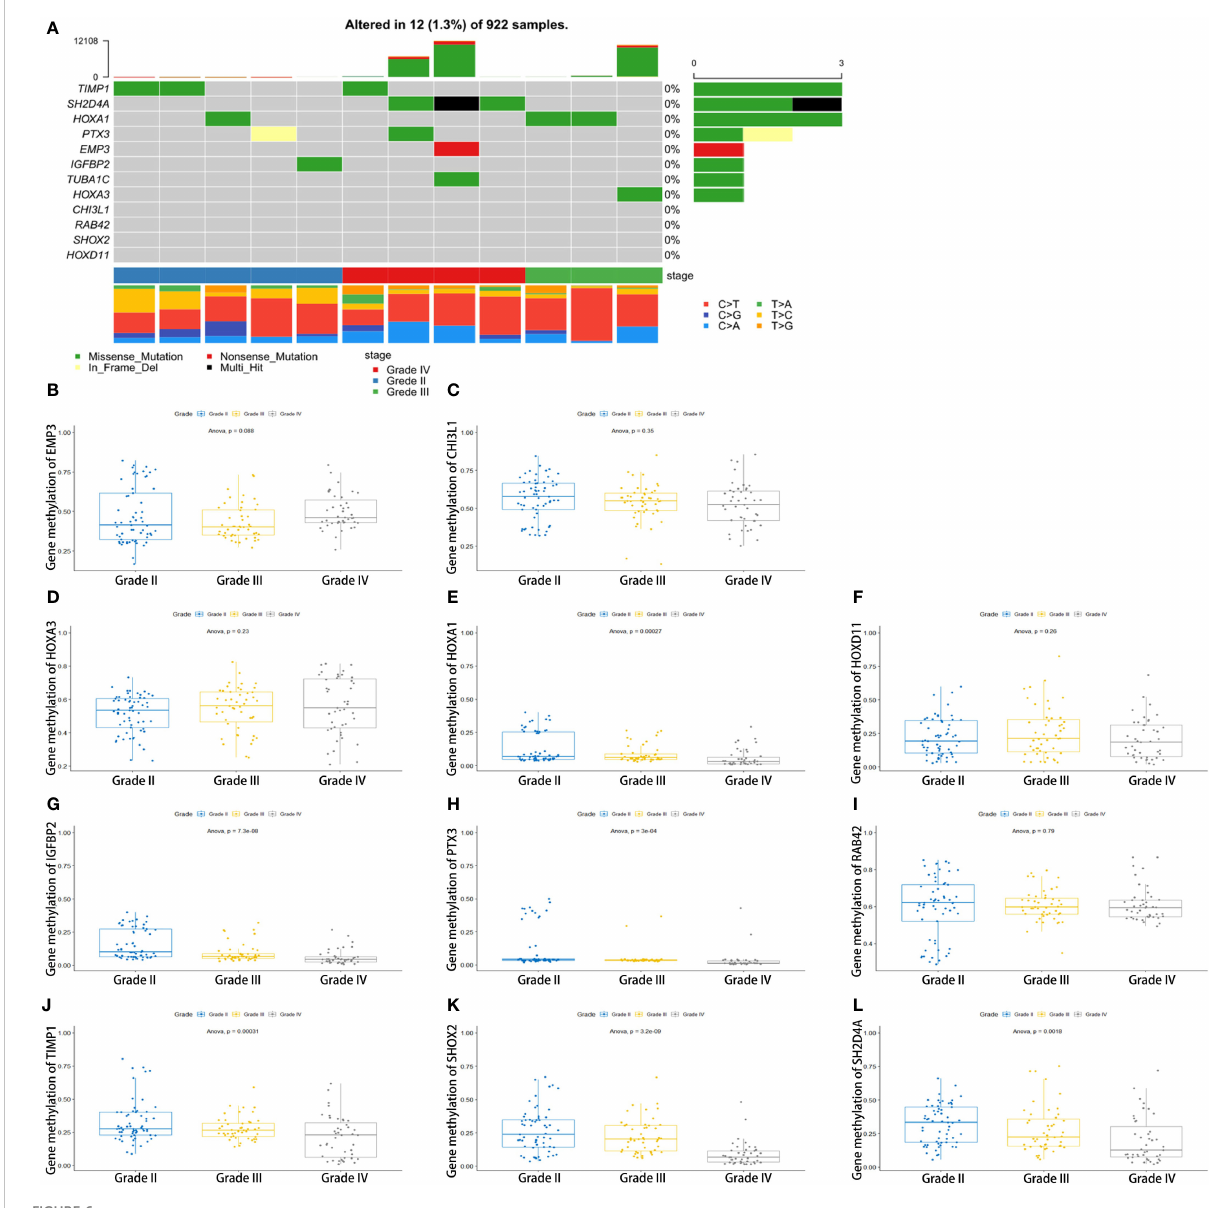
FIGURE 6 Genomic alterations and methylation analysis of the key genes in glioma samples. (A) The somatic mutation of the 12 genes. (B – L) The methylation analysis of the 12